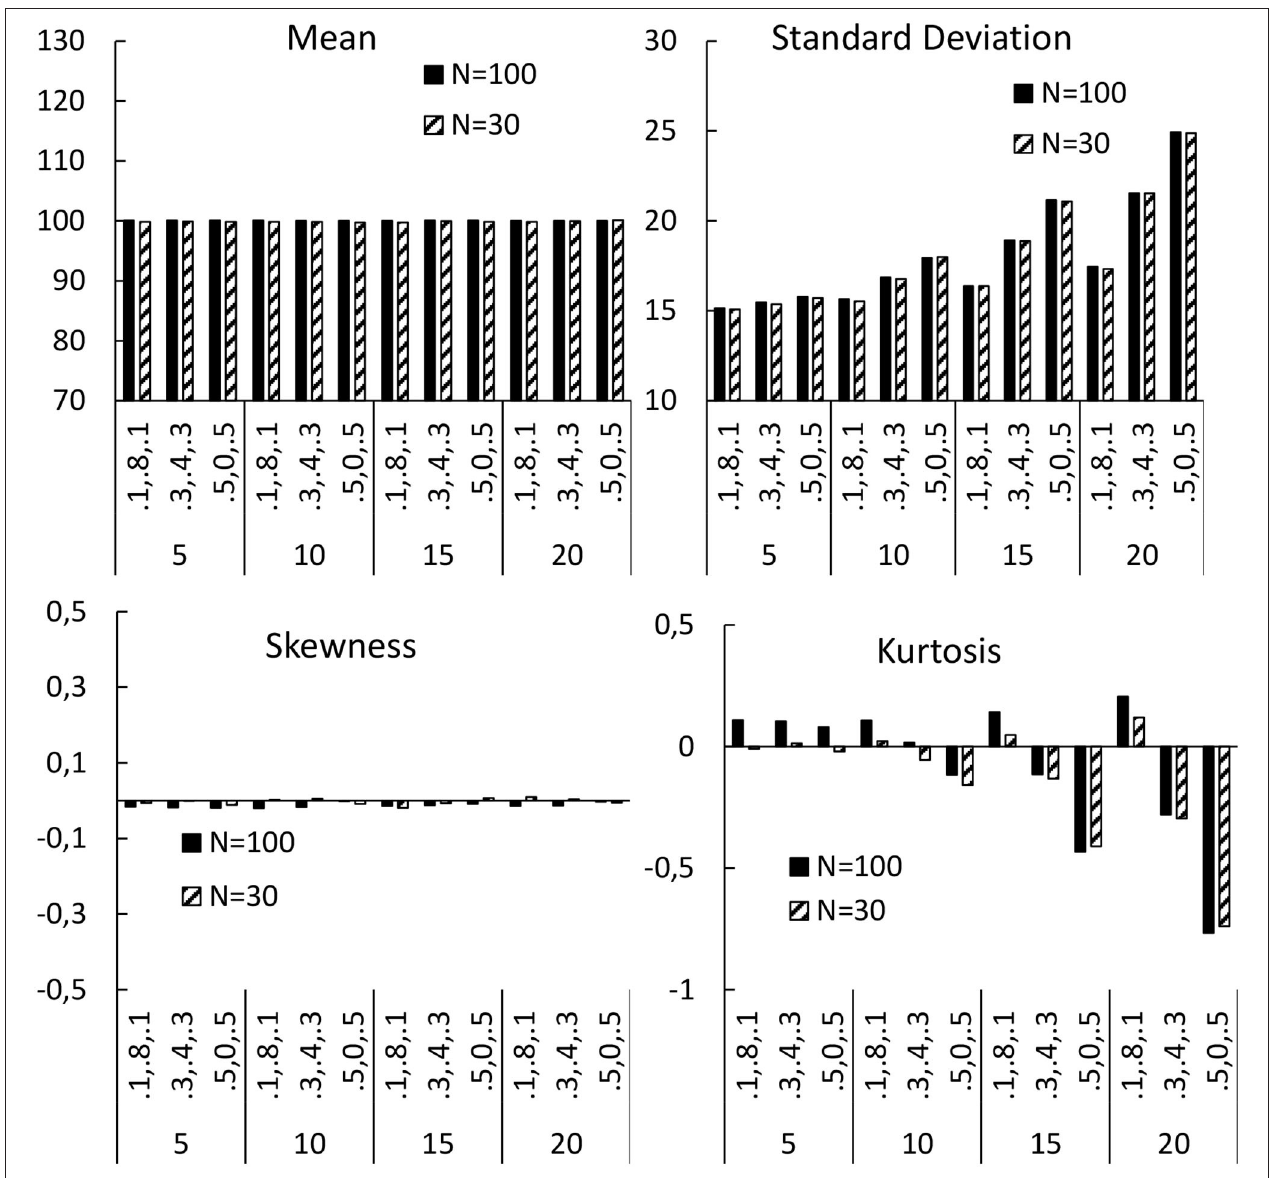
FIGURE 2 | Means for the sample mean, standard deviation, skewness, and kurtosis, calculated under each condition. Bottom axes are the effect of motivation (5, 10, 15, 20), and the proportion of the sample taking a particular attitude to a treatment (0.1, 0.8, 0.1 = 10% negative, 80% neutral, 10% positive; 0.3, 0.4, 0.3 = 30% negative, 40% neutral, 30% positive; 0.5,0, 0.5 = 50% negative, 0% neutral, 50%